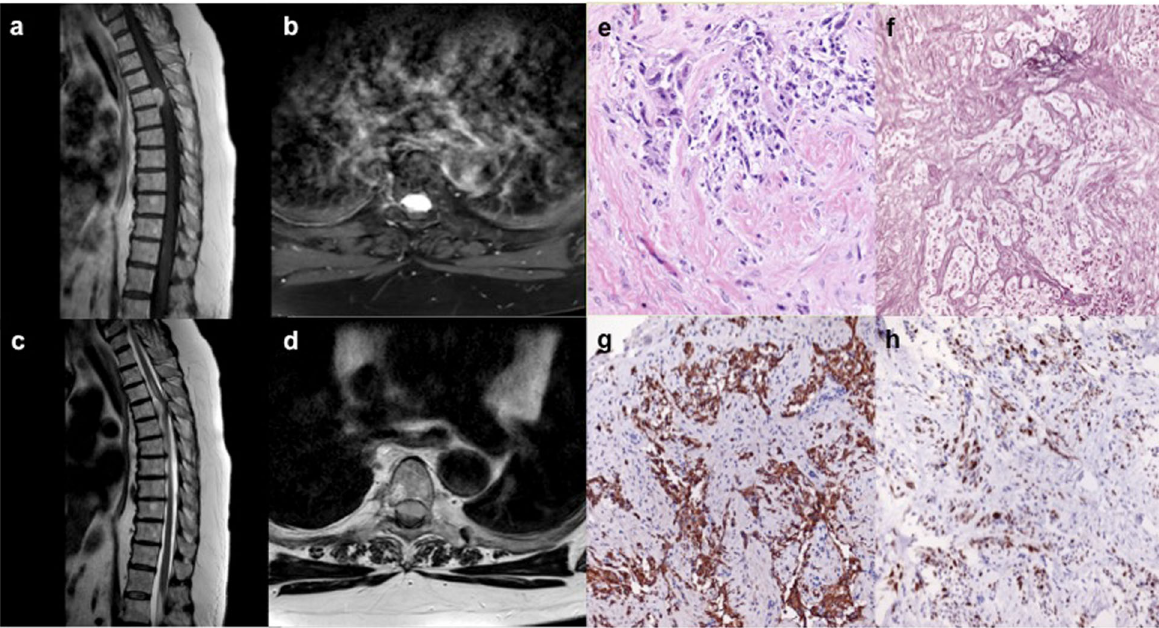
Fig. 2 Imaging and histopathology of the gliosarcoma. a Representative sagittal and ( b ) axial slices from T1-weighted MRI after contrast administration show a homogeneously enhancing intradural, extramedullary lesion anterior to the spinal cord at the T4 level with associated cord compression seen on ( c ) sagittal and ( d ) axial slices on T2-weighted MRI. e Biphasic architecture is seen on hematoxylin & eosin staining, including ( f ) reticulin rich sarcomatous regions, interspersed with ( g ) GFAP-positive glial regions, and ( h ) an elevated Ki-67 proliferative index of ~10 –